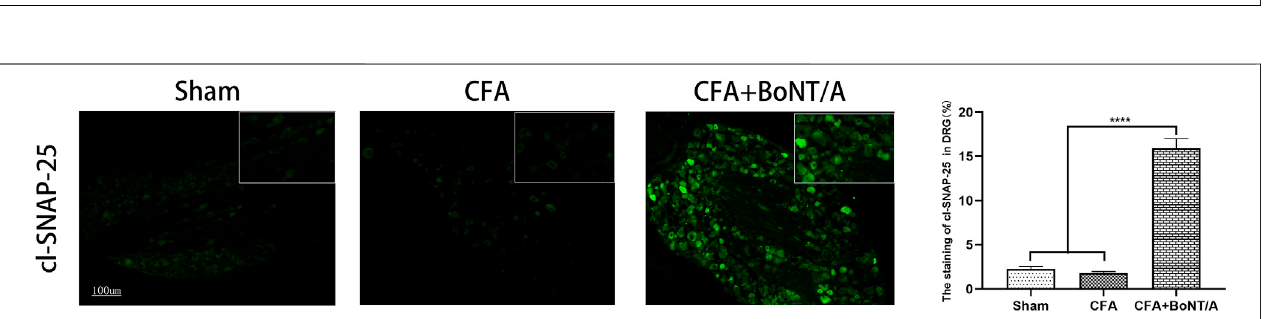
Frontiers in Pharmacology |